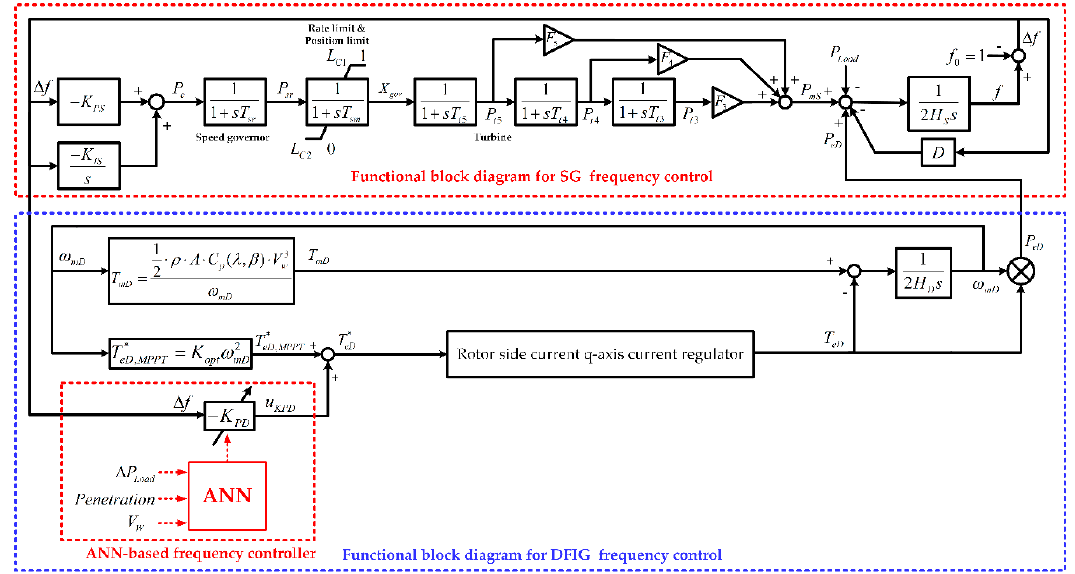
Figure 1. Block diagram for a frequency control system. SG: synchronous generator, ANN: artificial neural network, DFIG: doubly fed induction generator.